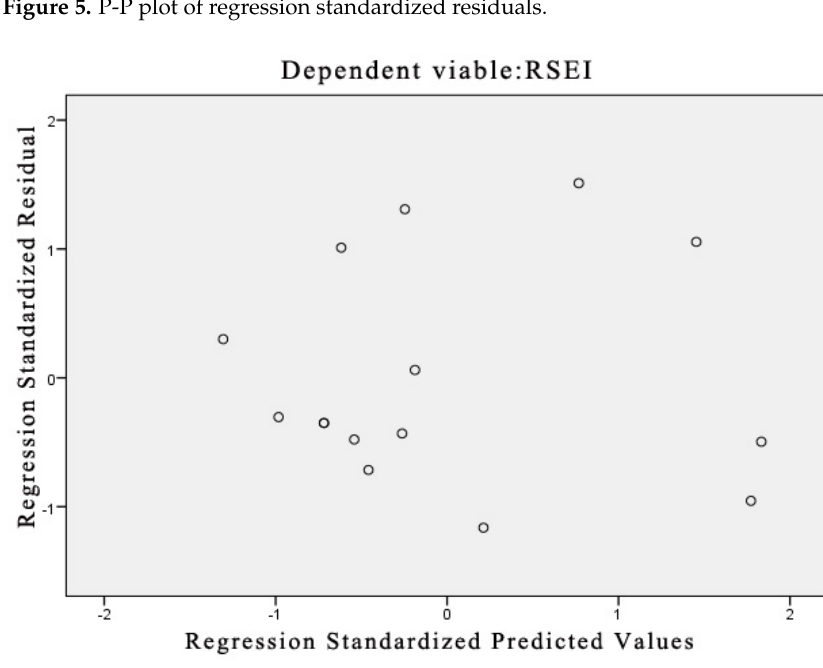
Figure 6. Scatter Figure 6. Scatter diagram.